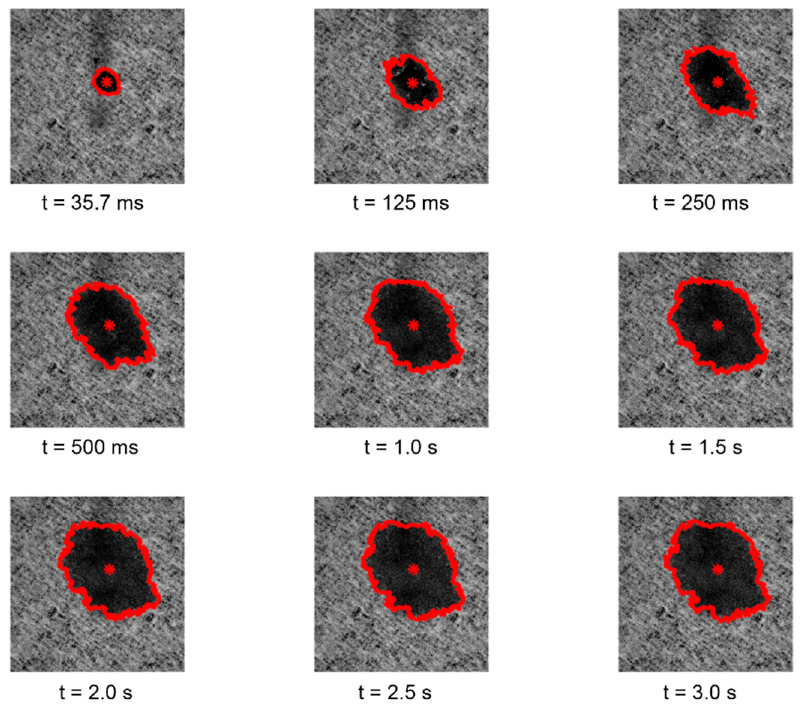
Figure 11. Spreading dynamics of a liquid droplet from t = 35.7 ms to 3 s for the tissue-paper sample Bd sl .